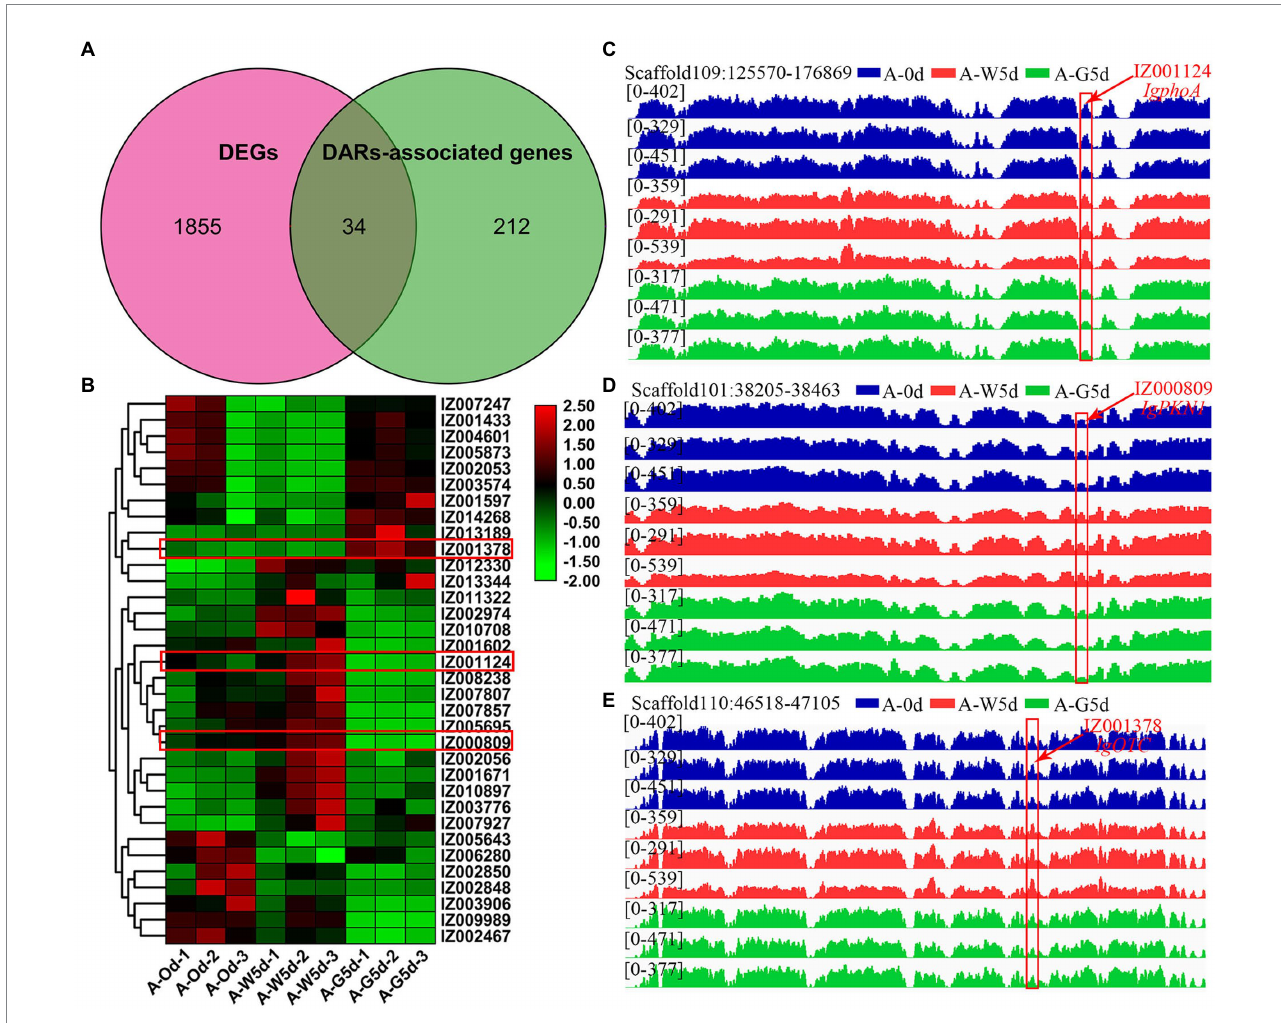
FIGURE 6 Integration analysis of ATAC-seq and RNA-seq. (A) Venn diagram of shared genes between DEGs and DARs-associated genes by RNA-seq and ATAC-seq. (B) Heatmap of 34 shared genes visualizing the changes in the expression profiles in A-0d, A-W5d, and A-G5d. (C) Overlapping analysis of IgphoA gene in DEGs and DARs-associated genes by RNA-seq and ATAC-seq. (D) Overlapping analysis of IgPKN1 gene in DEGs and DARs-associated genes by RNA-seq and ATAC-seq. (E) Overlapping analysis of IgOTC gene in DEGs and DARs-associated genes by RNA-seq and